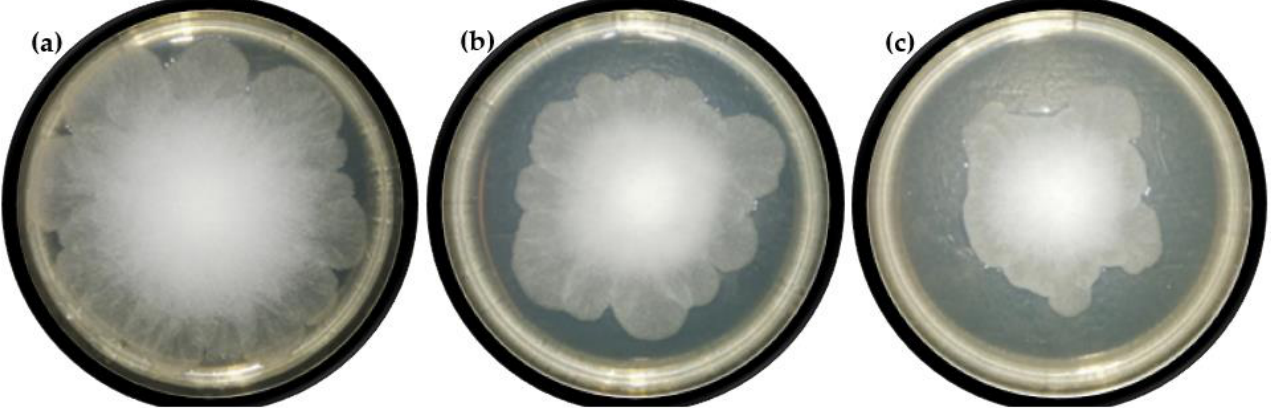
Figure 4. Photographs of R. oryzae mycelium after 4 days of cultivation on PDA medium containing the tested ester at the concentration of ( a ) 0, ( b ) 0.5 and ( c ) 1 mM, respectively. T o the authors’ best knowledge, butyl dihydrocaffeate and other lipophilized ester